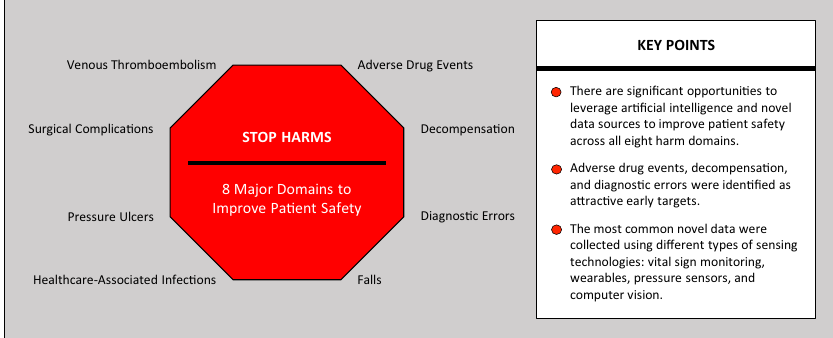
Fig. 2 Summary of major domains of harm and key points. The fi rst panel highlights the eight major domains of harm. The second panel summarizes the key points from the